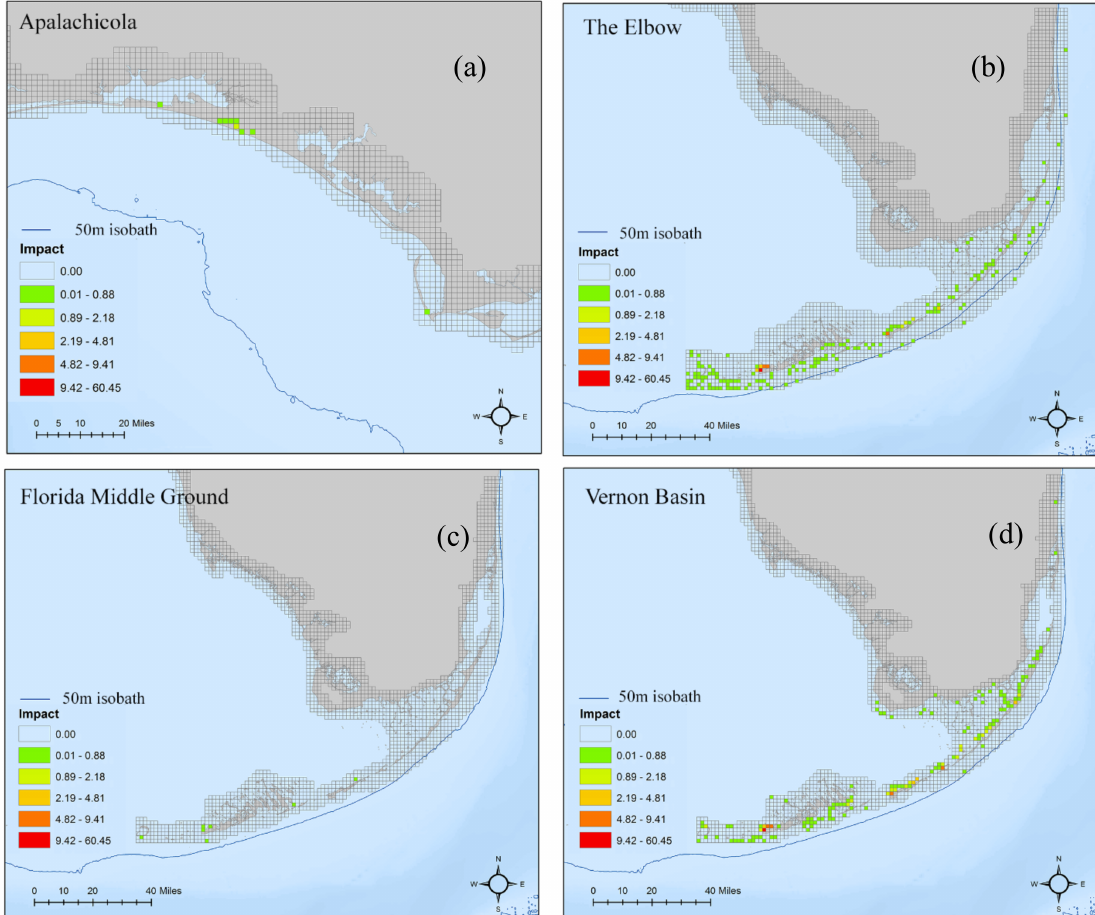
Figure 6. Spatial distribution of the impacts from the scenarios that had a coastal impact. ( a ) (top left) indicates the coastal impact from Apalachicola. ( b ) (top right) indicates coastal impacts from The Elbow. ( c ) (bottom left) indicates coastal impacts from Florida Middle Ground and ( d ) (bottom right) indicates the coastal impacts from Vernon Basin. With the exception of Apalachicola where the coastal impacts occurred on the Florida Panhandle, the majority of impacts were seen along the Florida Keys and Atlantic Coast of